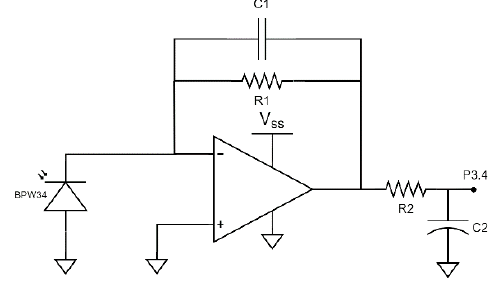
Figure 2. Circuit used for measurement of the solar irradiance, including the photodiode and the signal conditioning circuit.